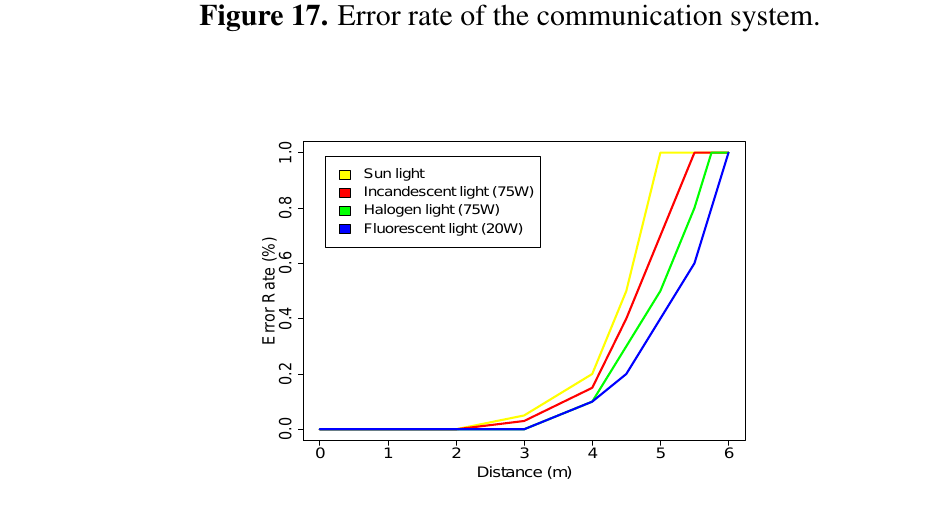
Figure 17. Error rate of the communication